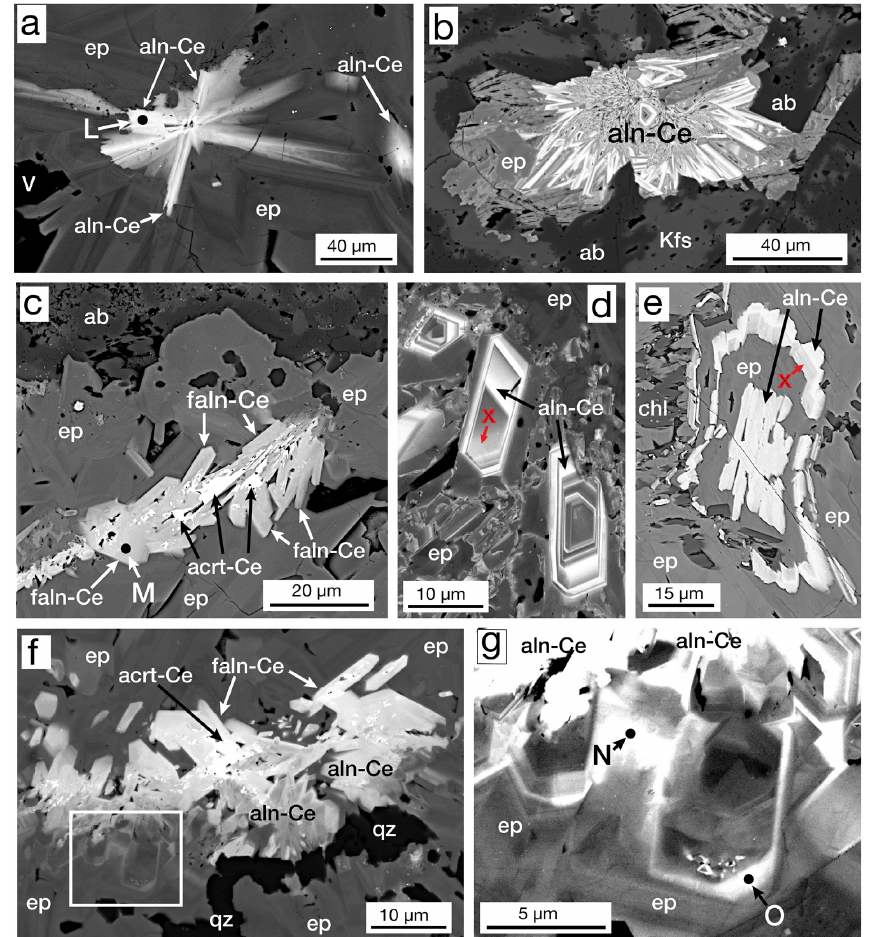
Figure 9. BSE images: (a) “starburst” allanite-(Ce) (aln-Ce) in the core of an epidote (ep) mass, sample MF1-1597. (b) Mass of radiating allanite-(Ce) (aln-Ce) with epidote (ep), albite (ab), and K-feldspar (Kfs), sample MF2-1824. (c) Mass of ferriallanite-(Ce) (faln-Ce) with aluminocerite-(Ce) (acrt-Ce) in their cores in an epidote (ep) mass with albite (ab), sample MF1-1597. (d) Zoned crystals of allanite-(Ce) (aln-Ce) with areas of REE-bearing epidote (X) in patchy REE-rich epidote (ep), sample MF2-1824. (e) An allanite-(Ce) core (aln-Ce) followed by epidote (ep) and then REE-bearing epidote (X) followed by allanite-(Ce) surrounded by epidote (ep) and chlorite (chl) in sample MF2-1824. (f) Allanite-(Ce) (aln-Ce) and ferriallanite-(Ce) (faln-Ce) in the core of a 400 × 450µm epidote (ep) mass with a late vein of quartz (qz). The rectangle is enlarged in (g) , sample MF1-1597. (g) Enlargement of area in (f) showing clinozoisite (czo; spot N) and epidote (ep; spot O) both enriched in LREE, just below allanite-(Ce) (aln-Ce). Data for analytical spots L–O are given in Table 4.